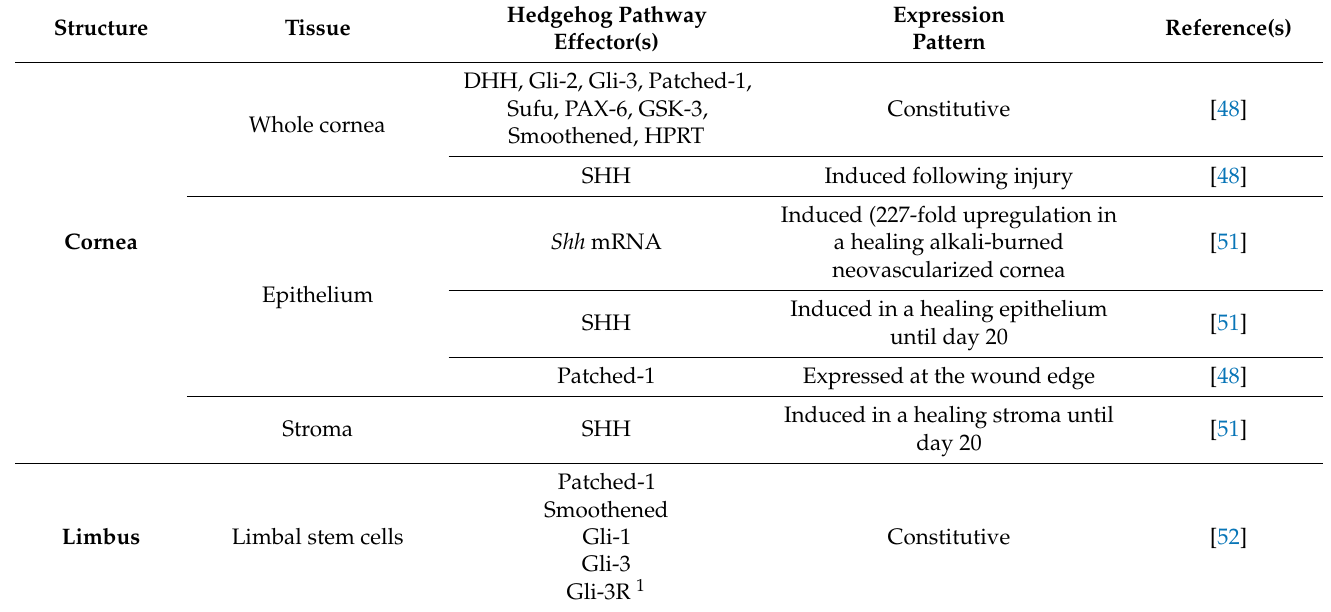
Table 1. Distribution of Hedgehog pathway effectors in the ocular surface of mice (DHH = Desert Transferase, PAX-6 = Paired Box Protein 6, SHH = Sonic